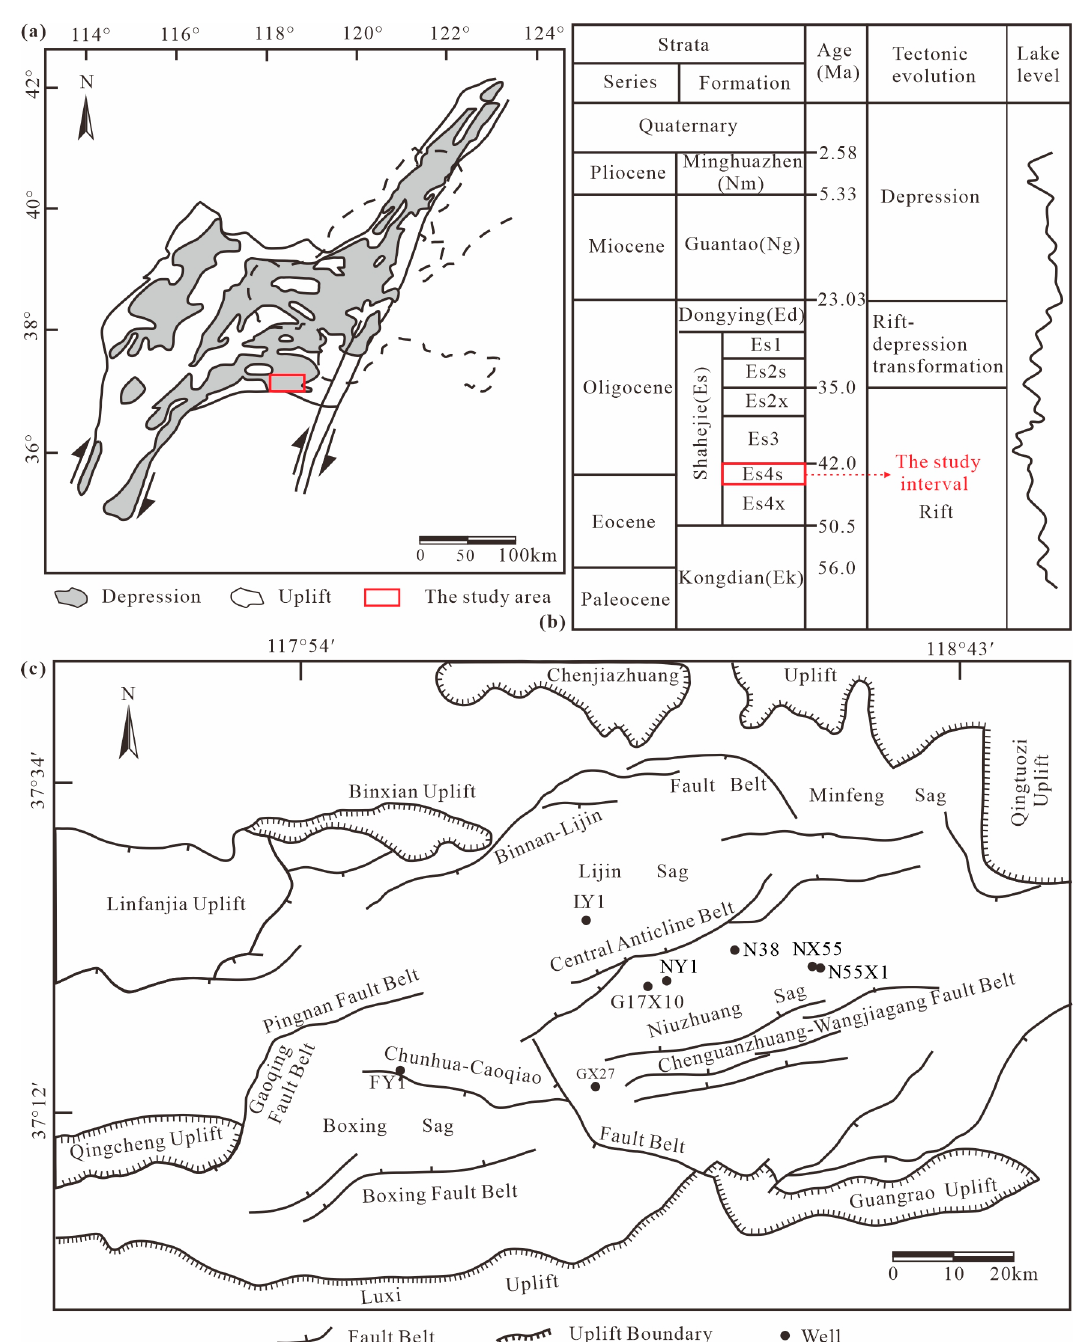
Figure 1. ( a ) The structural map of Bohai Bay Basin and the location of Dongying Depression (modified after [29]). ( b ) The strata and tectonic evolution of the Dongying Depression (modified after [45]). ( c ) The structural map of the Dongying Depression showing key well locations (used with permission and modified from the Geoscience Research Institute of Shengli Oilfield Company).